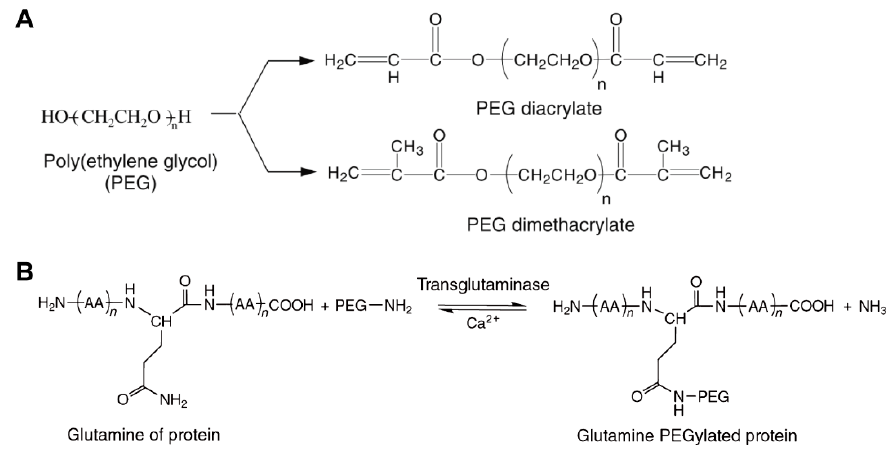
Figure 9. ( A ) Poly(ethylene glycol) (PEG) di(meth)acrylate synthesis from the PEG monomer to form hydrogel and ( B ) enzymatic PEGylation by transglutaminase. Reprinted from [72,73]. Copyright